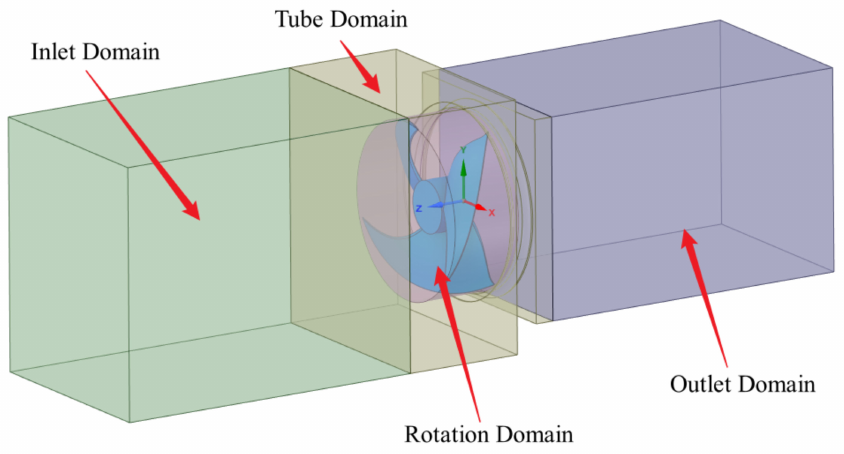
Figure 4. Flow domains of the model.